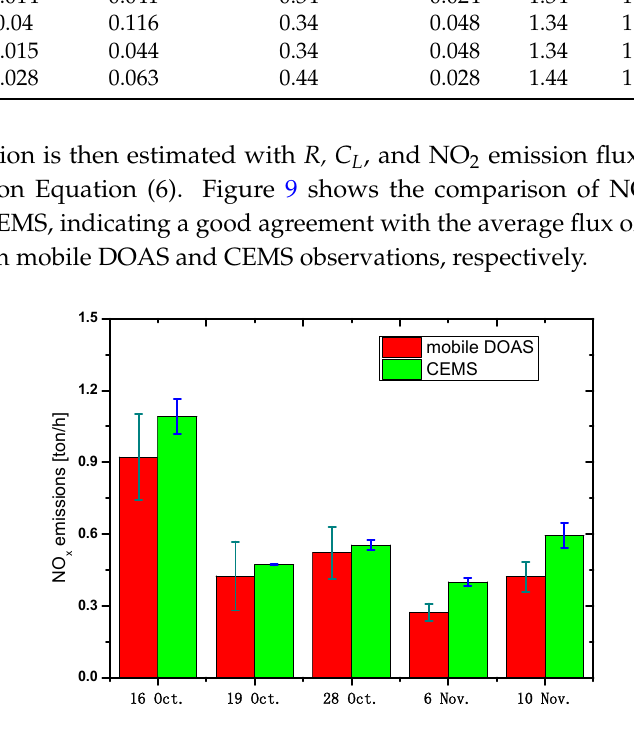
Figure 9. NO x emission flux from mobile DOAS and CEMS observations.